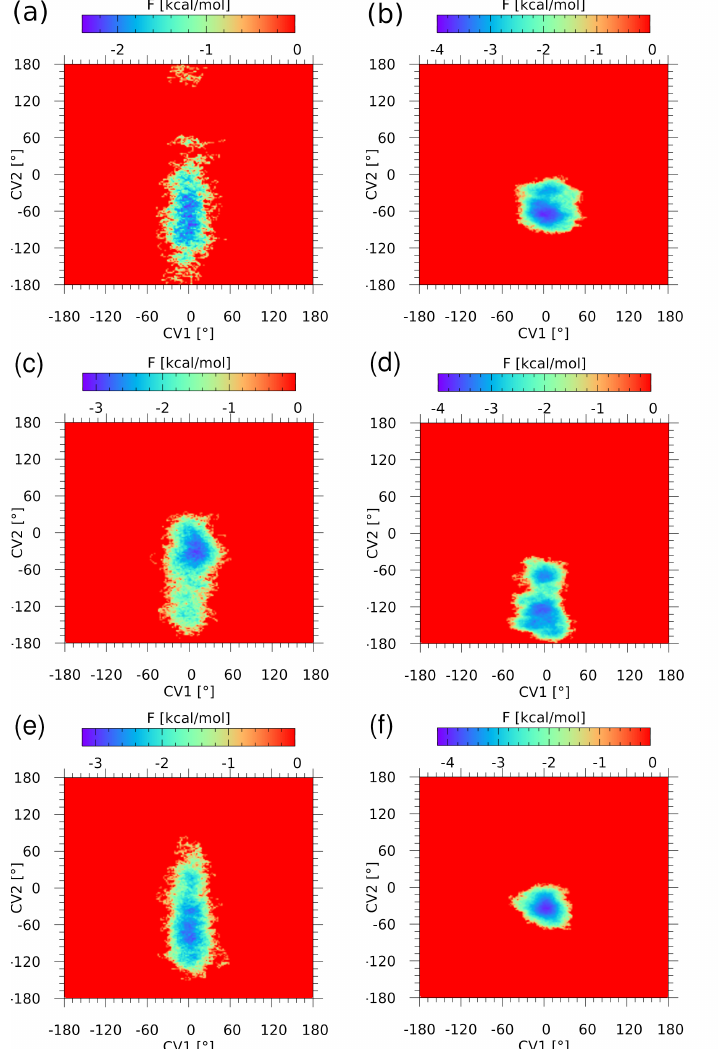
Figure 3. Free energy (F) surface reconstructed from ( a ) the CPMD run and ( b ) the PIMD run (with NQE inclusion) for the AZM molecule, ( c ) the CPMD run and ( d ) the PIMD run for the AZM-T system, ( e ) the CPMD run and ( f ) the PIMD run for the AZM-TT system. The collective variables are the following dihedral angles: CV1 is the S1-C2-N4-C1 dihedral, and CV2 is the S1-C3-S2-O2B dihedral (see Figure 2 for atoms numbering